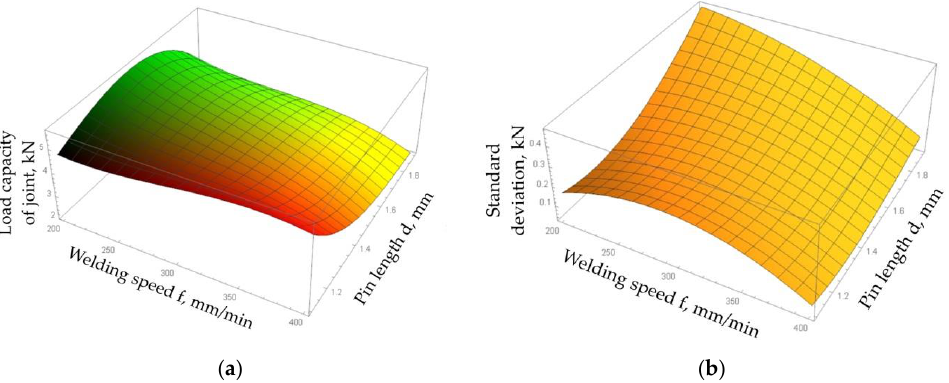
( b ) Figure 17. Plots of the regression function of ( a ) load capacity of the joint and ( b ) standard deviation of the process spread for a welding speed x 2 = 200 mm/min. The analysis of the graph of the regression function of the load capacity of joints ob- tained for a rotational speed of 1303 rpm showed that the load capacity of the joint de- creased with the increase in welding speed (Figure 18a). The value of the standard devia- tion of the process spread also decreased with the welding speed (Figure 18b). The local maximum of the regression function of the load capacity (5.71 kN) in a saddle point was